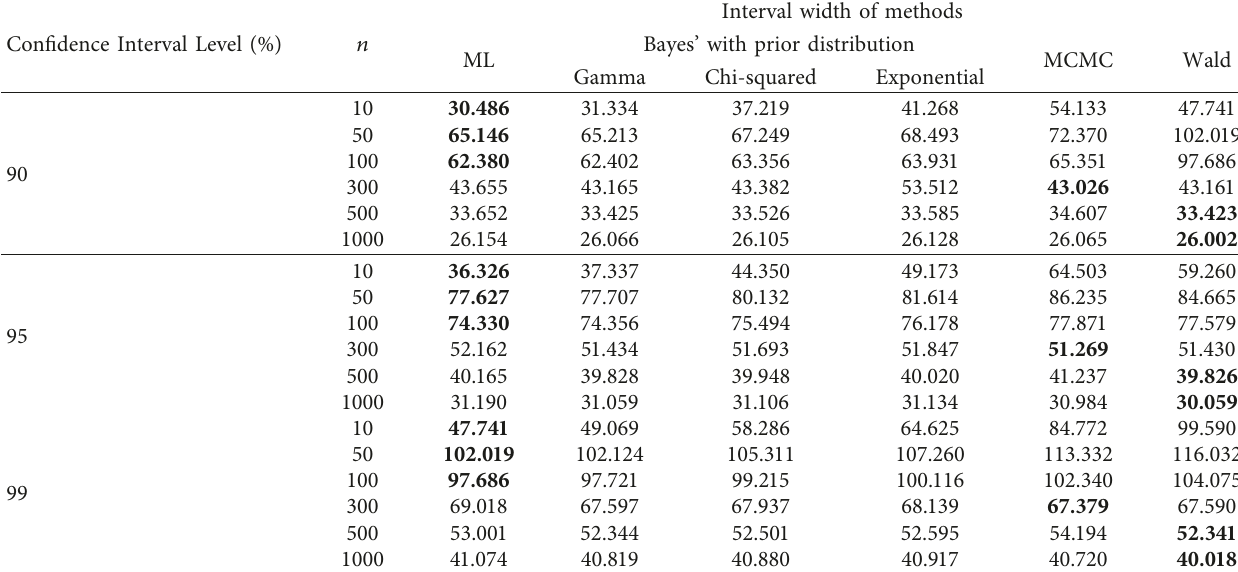
Figure 10: The normal Q-Q plots of daily PM 2.5 in the six sample sizes. Table 5: The interval width via 90%, 95%, and 99% confidence